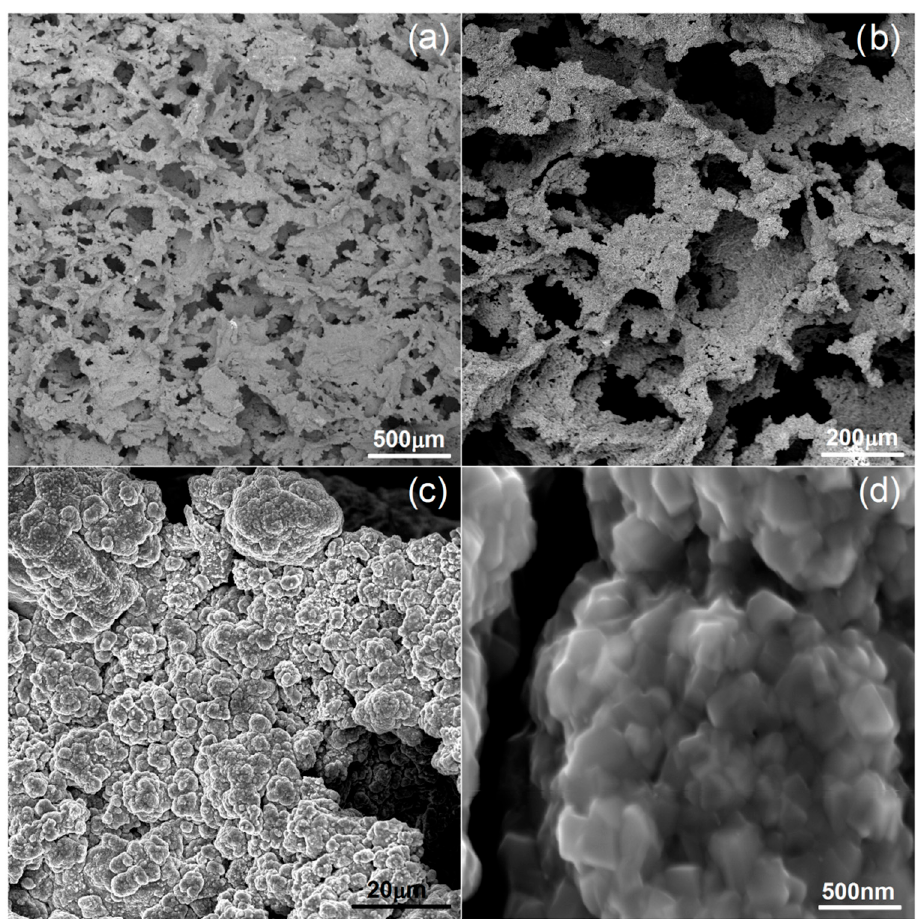
Figure 6. SEM micrographs of Ti40Ta3Ag foam: ( a – d )—various magnifications.